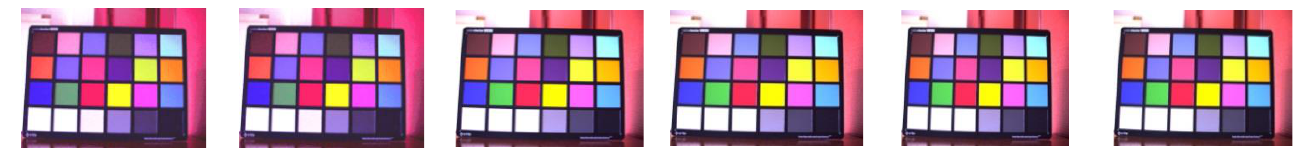
Figure 5. Enhanced images associated to f 3 , f 6 , f 18 , f 24 , f 33 , f 45 , from left to right.